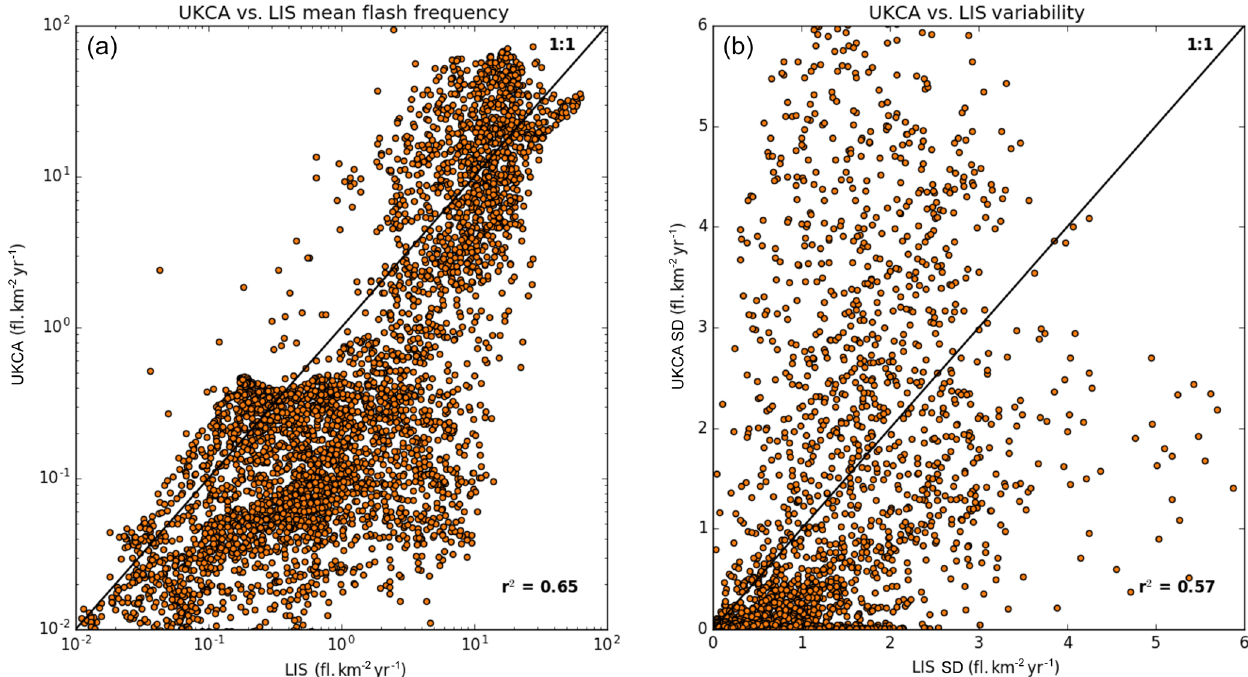
Figure 2. Scatter plot of the modelled versus the LIS-observed multi-annual mean lightning flash density (a) and the standard deviation (b) .